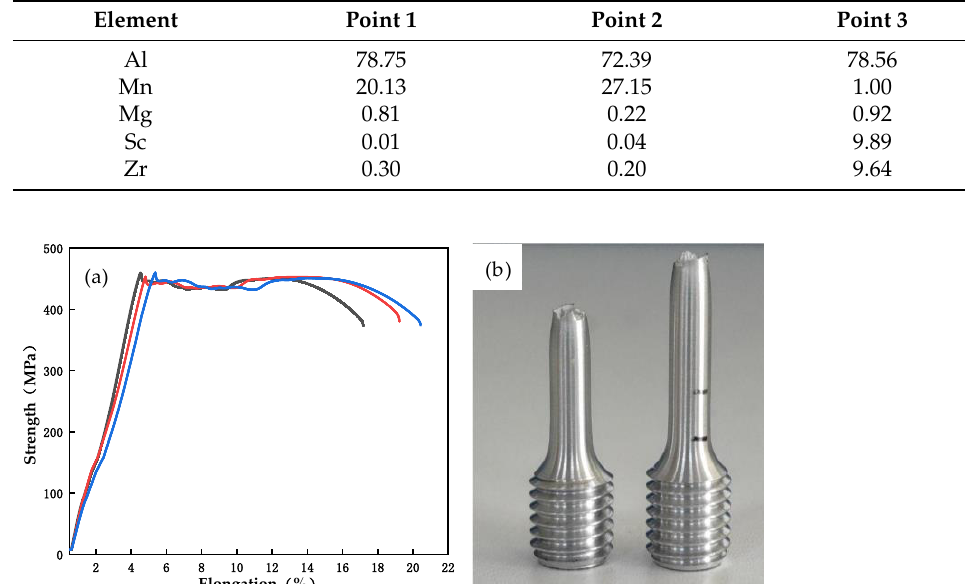
Table 5. EDS analysis of the second phases around grain boundaries shown in Figure 9d. (wt.%).